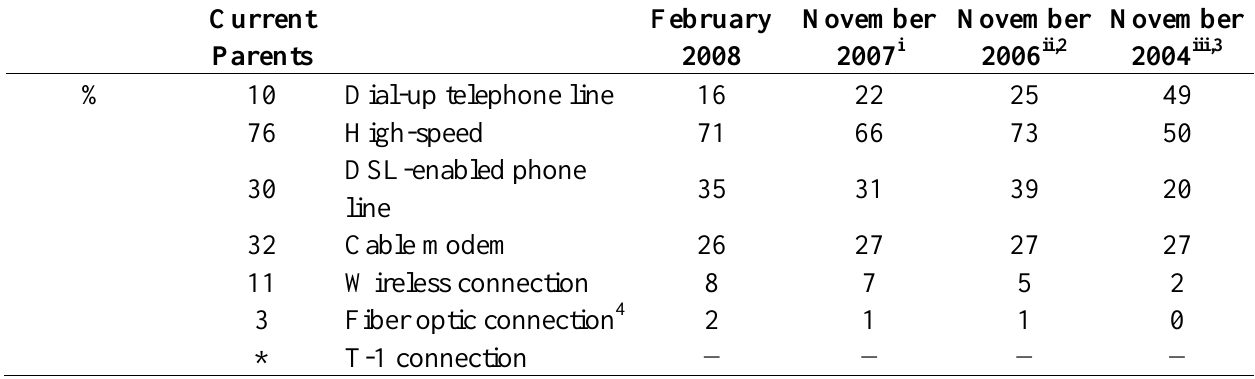
Table A1. At home, do you connect to the internet through a dial-up telephone line, or do you have some other type of connection, such as a DSL-enabled phone line, a cable TV modem, a wireless connection, a fiber optic connection such as FIOS or a T-1 1 ?